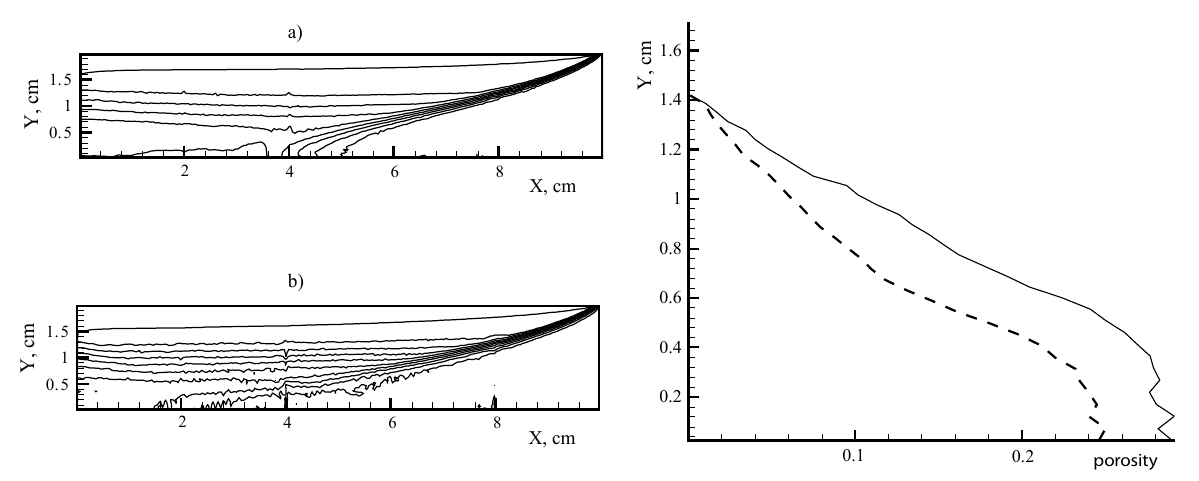
 cm: solid line is planar Figure 10: Porosity m for = 0.5 1 e statement; dashed line is cylindrical configuration.